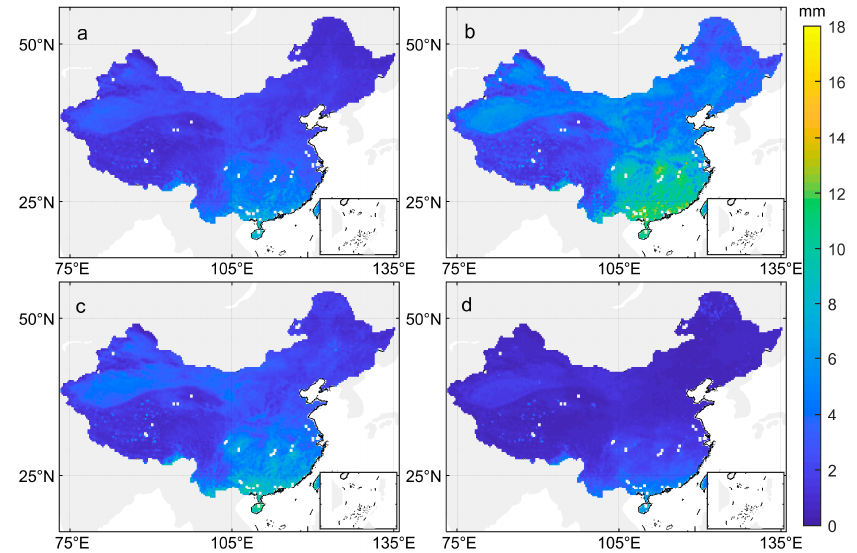
Figure 10. Distribution of seasonal RMSs between ERA-PWV and MOD-NIR-PWV in the six-year period studied over each grid point in ( a ) spring, ( b ) summer, ( c ) autumn, and ( d ) winter.